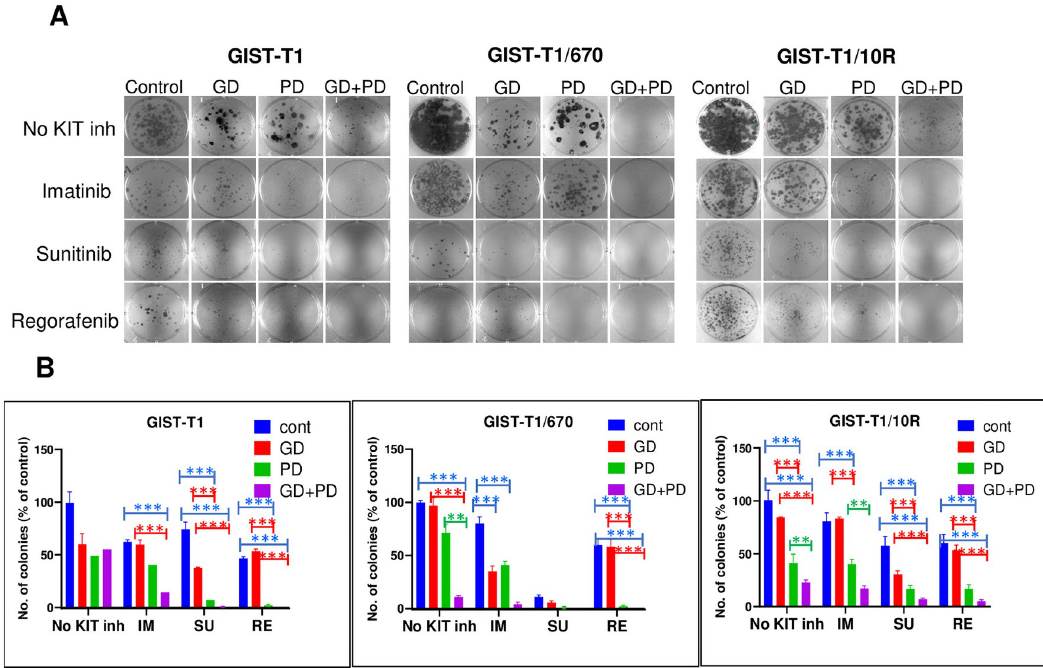
Fig 5. Effective reduction in colony growth after treatment with the KPM inhibitor cocktail. (A) Colony outgrowth assay to evaluate the long-term survival of GIST cell lines in the presence of indicated drugs. After 1-month duration of treatment, cells were allowed to grow in drug-free media for two weeks before staining with crystal violet. (B) Quantification of colony counts from the clonogenic assay, each column represents average of three wells. Each point represents mean ± standard error, n = 3. The data is representative of three independent experiments. p values for various combinations were compared within each KIT inhibitor treatment group. ( ��� p < 0.0001); ( �� p < 0.005); ( � p < 0.01).